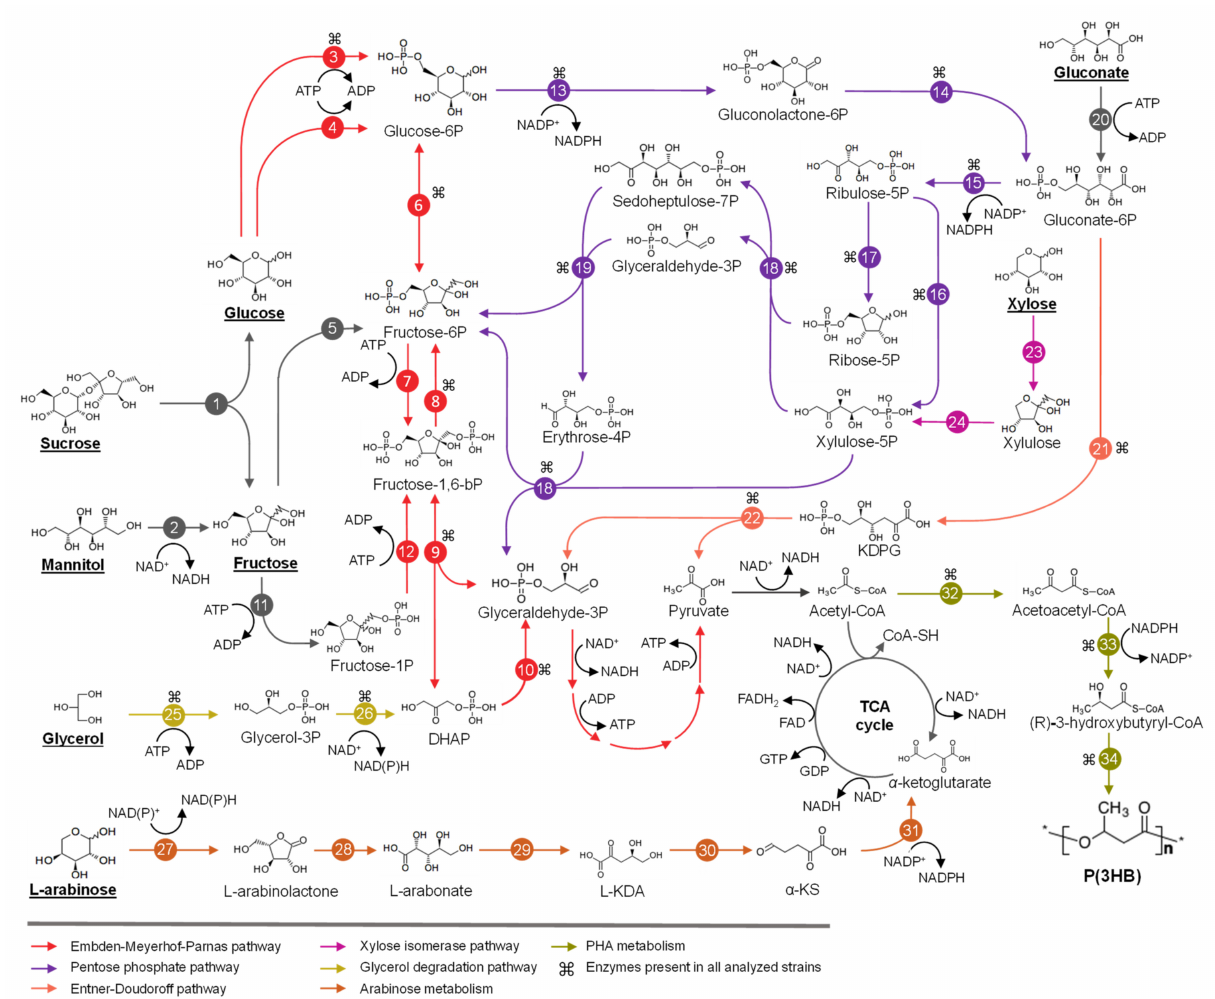
Figure 2. Proposed metabolic pathways from sugars and glycerol into the synthesis of polyhydroxybutyrate of Burkholderia sensu lato genera. Each reaction is represented with an arrow with the respective enzyme depicted with a number. Compounds with their name underlined are carbon and energy sources for these bacteria. Enzymes present in all analyzed genomes are marked with “ ⌘ ”.1, β -fructofuranidase (FFase), α -glucosidase (MalL); 2, mannitol dehydrogenase (MDH); 3, glucokinase (GLK); 4, glucose phosphoenolpyruvate transferase system (PTS) family transporter (glu-EII); 5, fructoki-